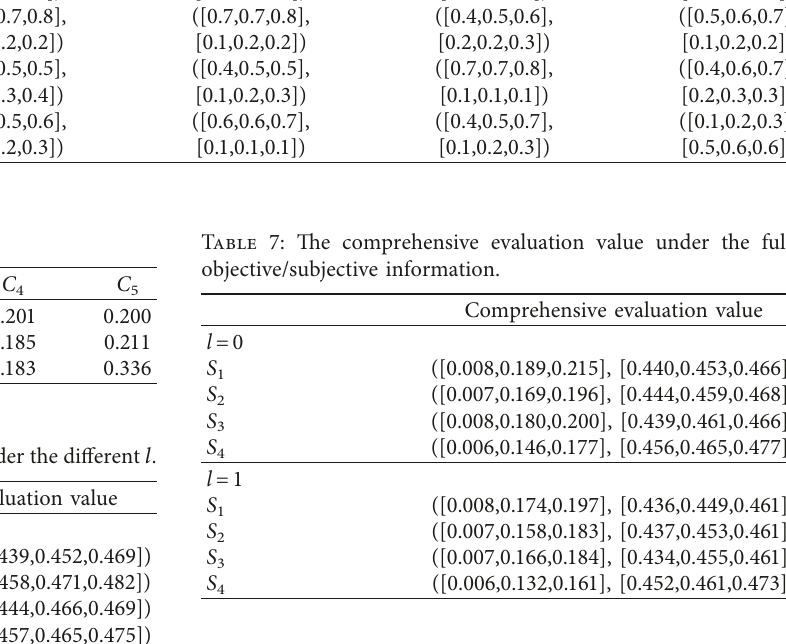
Table 4: Original evaluation criteria information matrix at the moment t